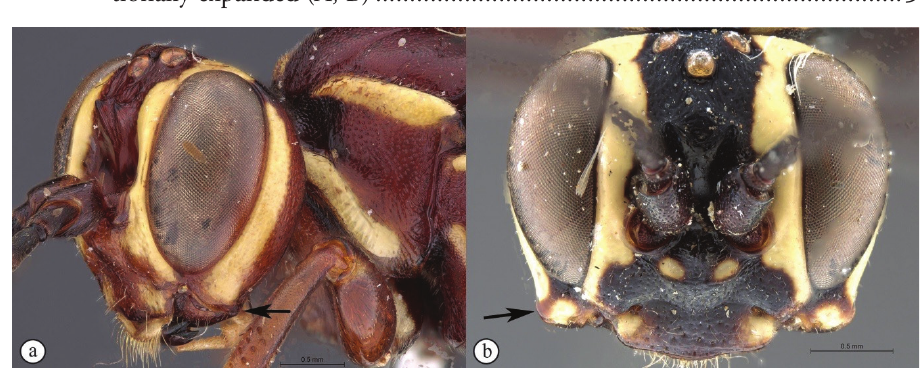
Lower gena produced into a long spade-like protrusion (A, B); clypeus excep- tionally expanded (A, B) ............................................................................. 5